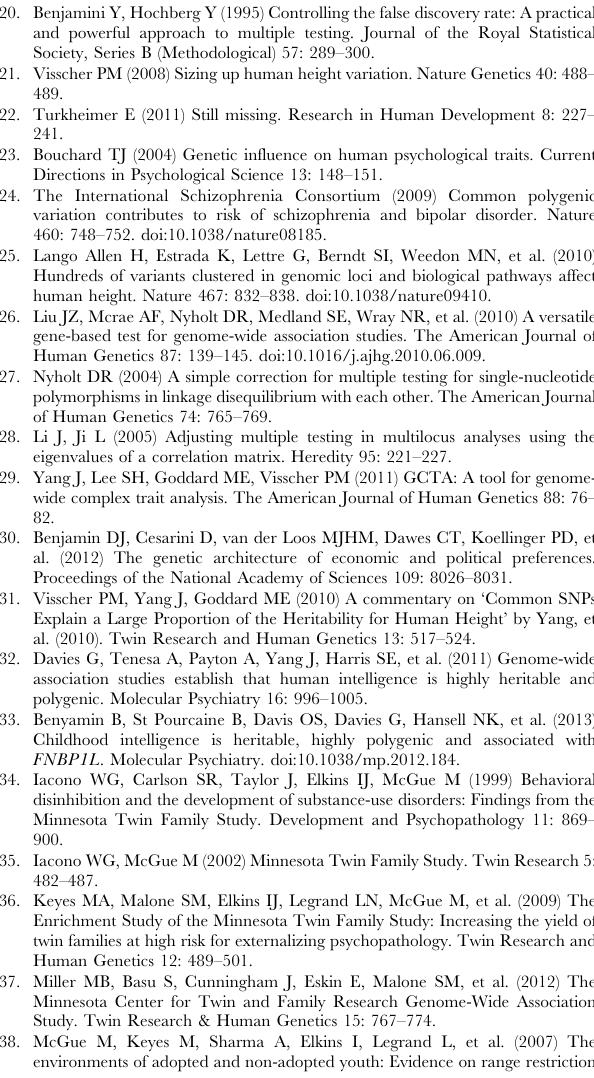
Table S1 Family patterns of GWAS data availability. Table S2 RFGLS parameter estimates for regression of FSIQ onto covariates